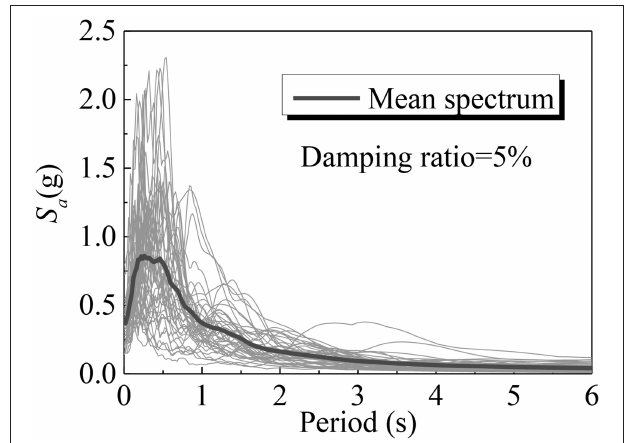
FIGURE 17 | Response spectra of the selected ground motion records.